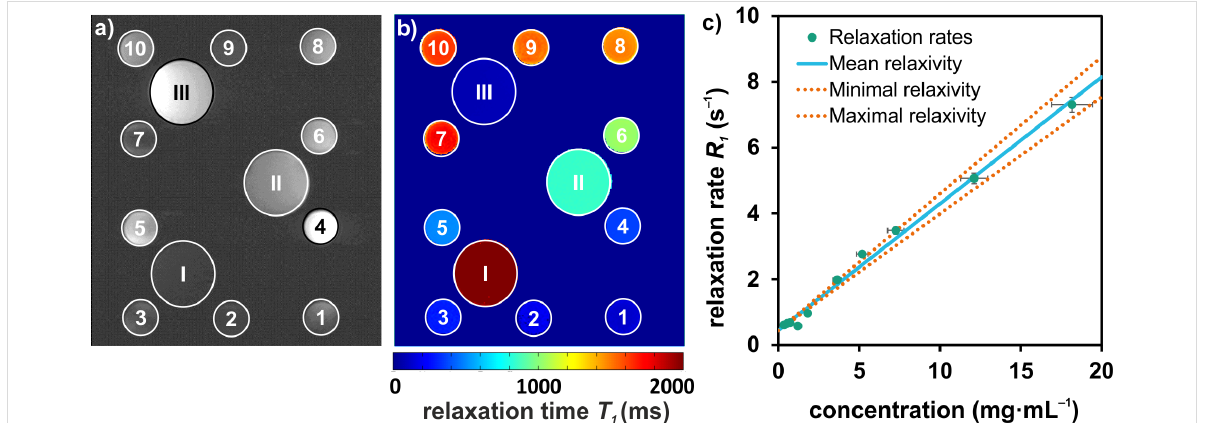
Figure 4: a) T 1 -weighted MR image of the CaF 2 :(Tb 3+ ,Gd 3+ ) NPs with different concentrations in the range from 0.4 to 18.2 mg·mL − 1 (1–10). I–III are reference samples of water and two concentrations of Magnevist. The different concentrations result in observable differences of the signal intensities. In b) the following T 1 -map with a corresponding color range from 0 to 2000 ms is shown. c) The relaxivity ( r = 0.385 ± 0.030 mL·mg − 1 ·s − 1 ) arises from the slope by plotting the relaxation rates over the concentrations. The errors of the relaxivity are given by the minimal and maximal slope.